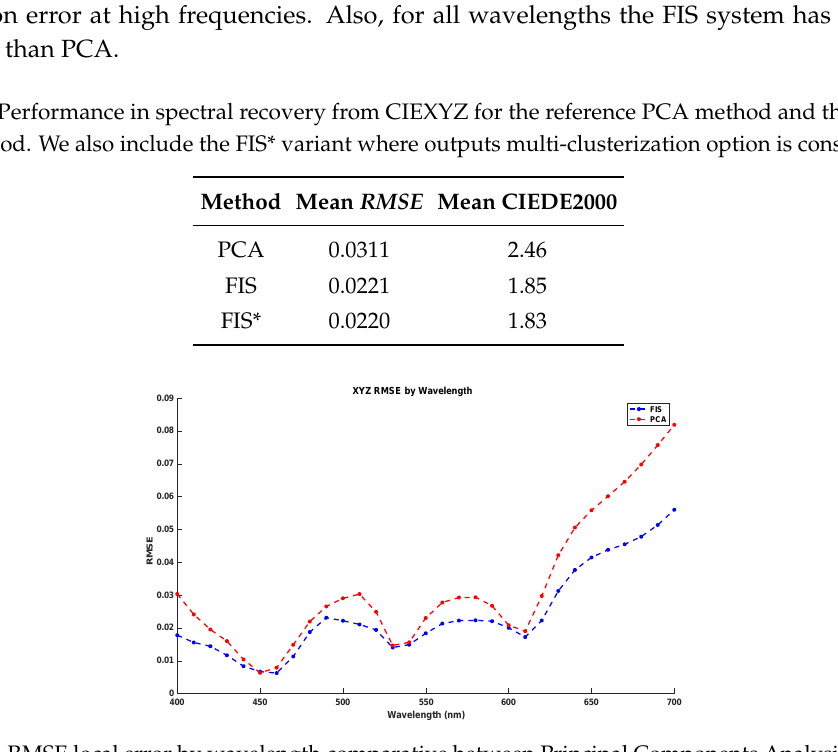
Figure 8. RMSE local error by wavelength comparative between Principal Components Analysis (PCA) and FIS using the CIEXYZ testing